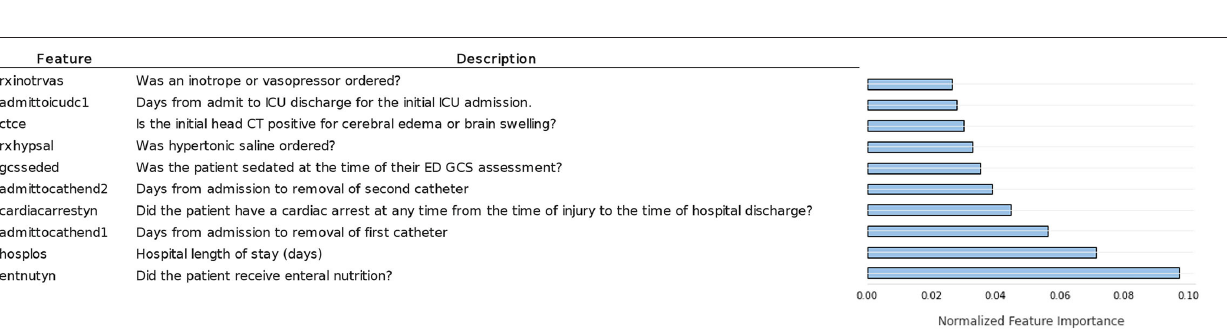
FIGURE 3 | Comparison of model scores per feature selection method: (A) k-Nearest Neighbors (KNN), (B) Artificial Neural Networks (ANN), (C) Random Forest (RF), (D) eXtreme Gradient Boosting (XGBoost).